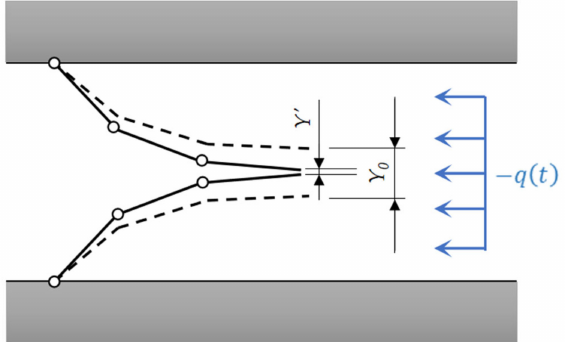
Figure 3. The simplified model and deformation of the